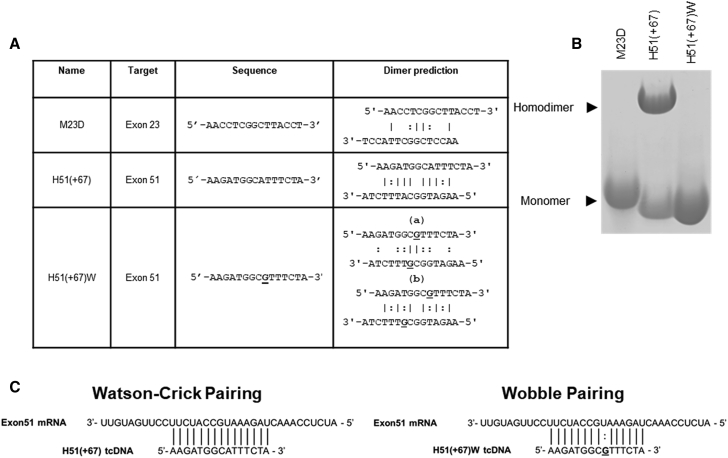
Sequence Modification Prevents Formation of Homodimer-like Structures(A) Propensity to form homodimer-like structures predicted with the OligoAnalyzer tool from IDT. The | symbol is used to depict Watson-Crick base pairing and the : symbol for wobble base pairing. For H51(+67)W, the most stable structure predicted by the OligoAnalyzer tool is shown in (Aa) and the original structure now containing wobble in (Ab). (B) Electrophoresis of tcDNA-ASOs in nondenaturing acrylamide gel to evaluate their ability to form homodimer-like structures. (C) Representation of the hybridization of tcDNA-ASO on the pre-mRNA target. H51(+67) tcDNA fully hybridizes with targeted pre-mRNA through Watson-Crick pairing (left); H51(+67)W tcDNA hybridizes with targeted pre-mRNA through one wobble pairing underlined (right).